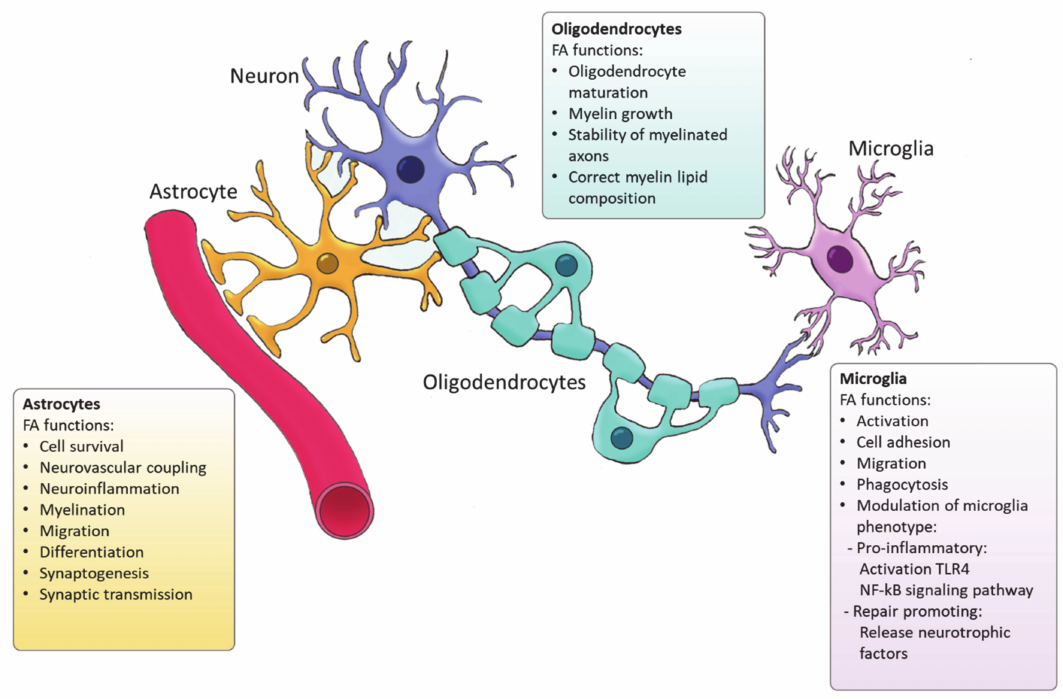
Figure 2. Functions of FA synthesized by glial